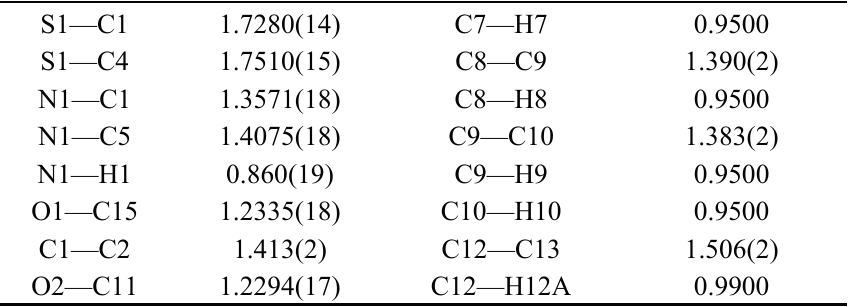
Table 2. Selected geometric parameters (Å, °).